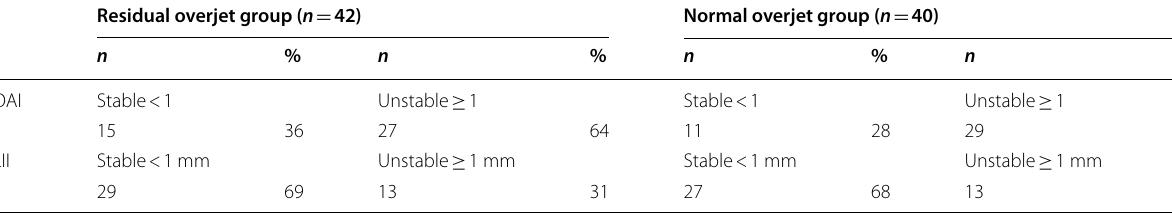
Table 3 Assessment of post-treatment stability